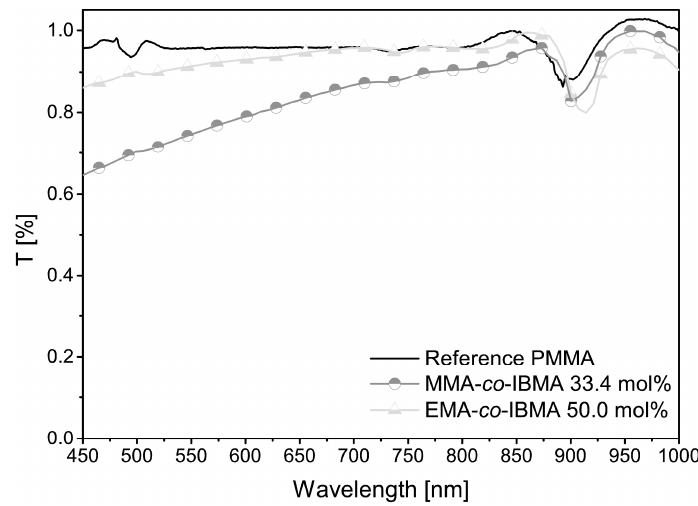
Figure 5. Transmittance spectra for 18 mm polymeric test samples in the spectral range from 450 to 1000 nm. Samples: PMMA reference, MMA- co -IBMA with 33.4 mol % comonomer content (azeotropic conditions) and EMA- co -IBMA with 50.0 mol % comonomer